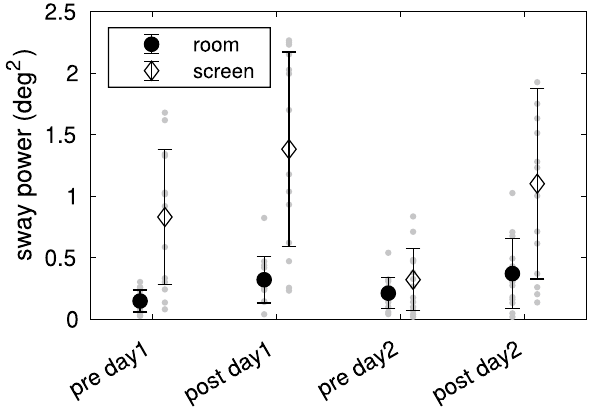
Figure 5. Body sway in response to visual scene tilts when viewing the room or the screen. Shown is the com sway power at the frequency of the scene tilt stimulus (0.5 Hz sine with 0.05 ◦ ). Room view and Screen view were measured at the beginning and the end of each session (pre and post) and on 2 different days (day1,